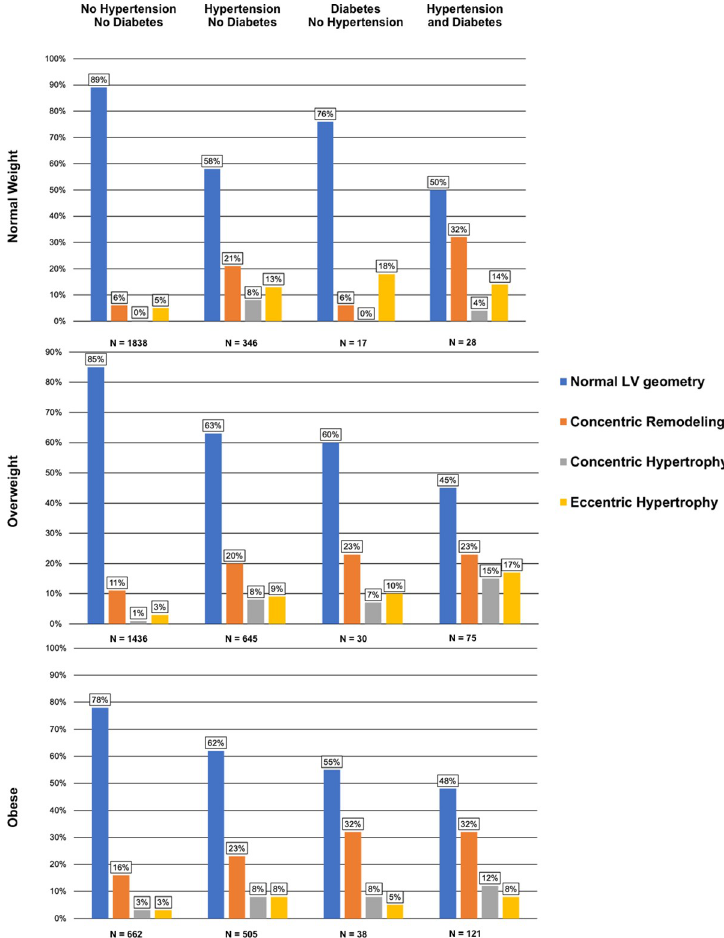
Fig 3. Distribution of left ventricular geometry. Frequencies (percentages) of left ventricular geometry (LV) patterns by body mass index (BMI) category (normal weight: BMI < 25kg/m 2 , overweight: 25kg/m 2 � BMI < 30kg/m 2 , obese: BMI � 30kg/m 2 ), hypertension status, and diabetes status.